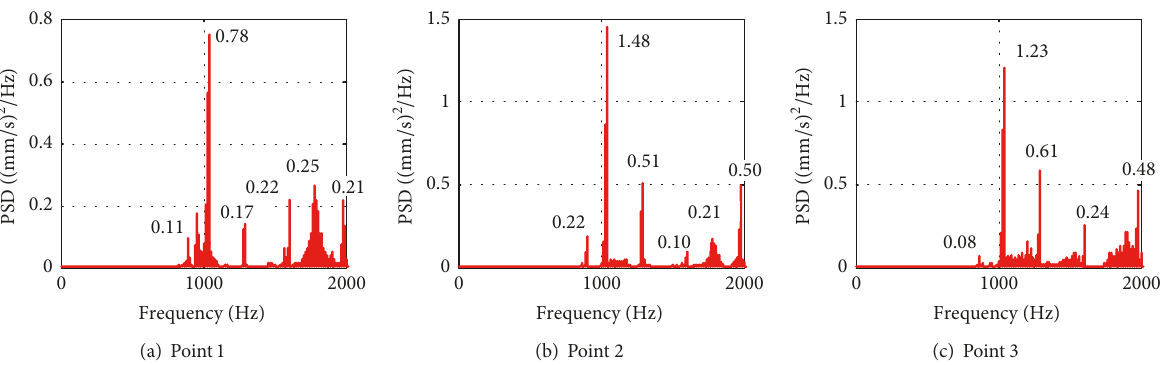
Figure 14: The measured PSD functions of cantilever cylindrical shell with hard coating at 3 measuring points.